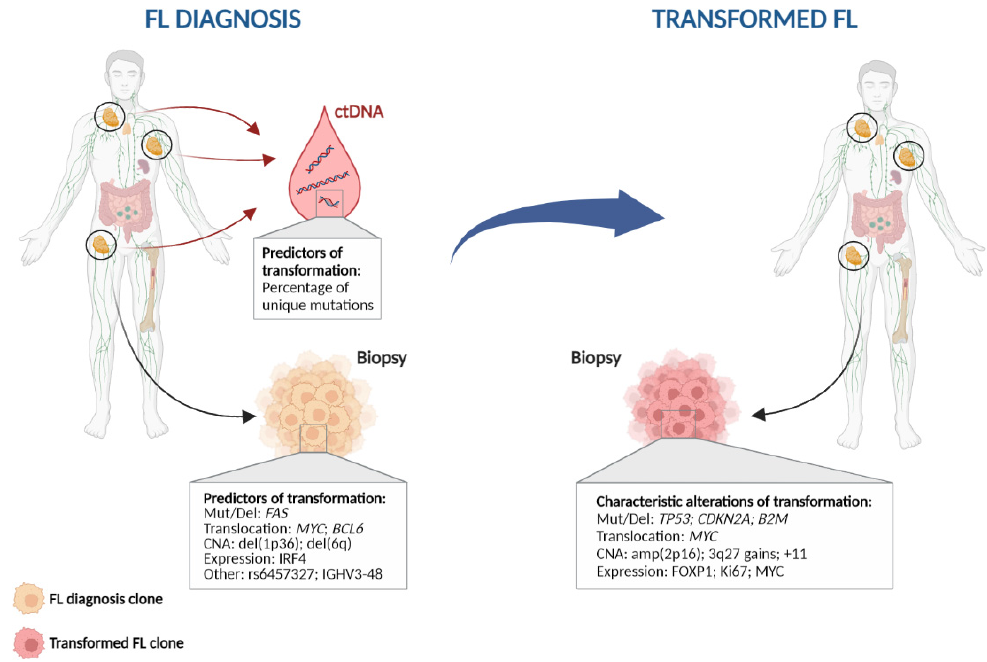
Figure 2. Characteristic genetic events in follicular lymphoma histological transformation. Left: Potential predictors of transformation; Right: Genetic alterations commonly found at histological transformation. CNA: copy number alteration; ctDNA: circulating tumour DNA; Mut/Del: mutation and/or deletion.